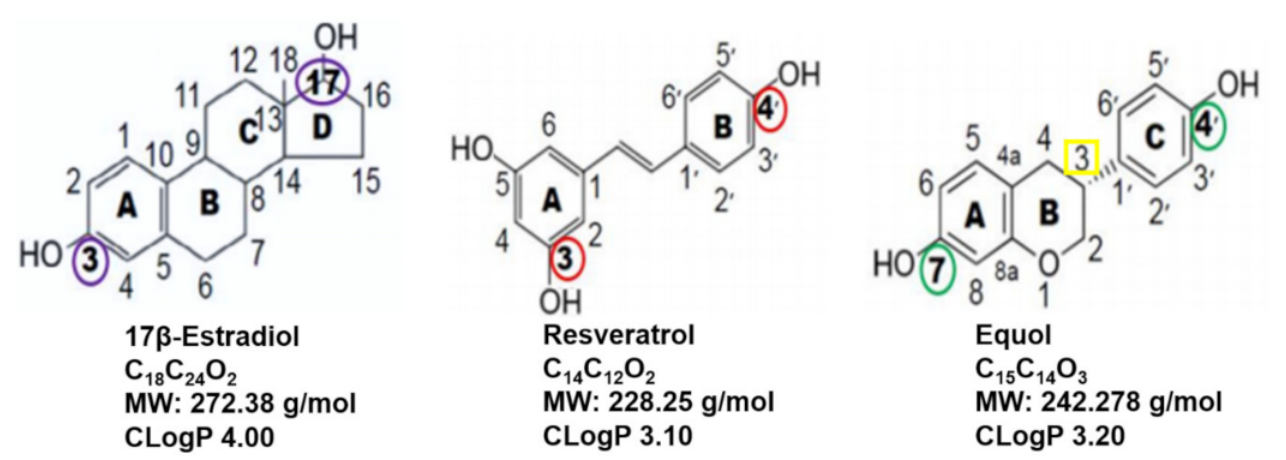
Figure 7. Comparison of the chemical structures, molecular formulas, molecular weights and CLogP values among 17 β - estradiol (E2), resveratrol and equol are shown. The CLogP = the logP value of a compound is its partition coefficient, which represents lipophilicity. In this figure, all-trans resveratrol and equol (with a chiral carbon at position 3—yellow rectangle) represents R-equol, racemic equol or S-equol (redrawn with permission from MDPI Journals [109]). For all three compounds, the functional hydroxyl (OH groups), which enable binding to ERs and are indicated by color circles: purple at carbon 3 and 17 for 17 β -estradiol; red at carbon 3 and 4 (cid:48) for resveratrol; and green at carbon 7 and 4 (cid:48) for